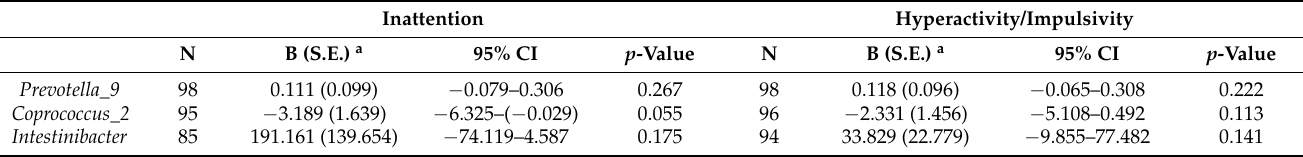
Linear regression models for the relative abundance of the selected genera (based on the Mann-Whitney U test) with the ADHD symptoms scores (inattention and hyperactivity/impulsivity) measured from participants with ADHD and controls and subthreshold ADHD; a Linear regression model without samples removed based on Cook’s distance and Leverage threshold; models adjusted for age, sex, BMI, diff_days and a random factor for family relatedness. There was no significant association after multiple testing correction (FDR); N = number of samples after the removal of outliers (N = 98 means no outliers were removed); B = coefficient; S.E. = standard error; CI = Confidence